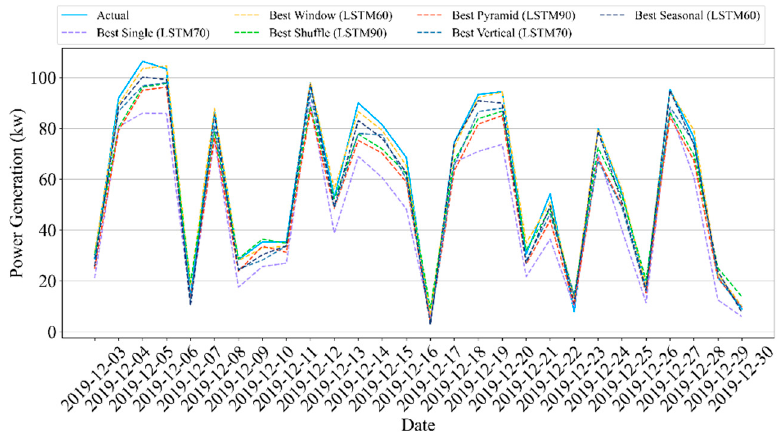
Figure 7. Results of daily forecasting of Site A.